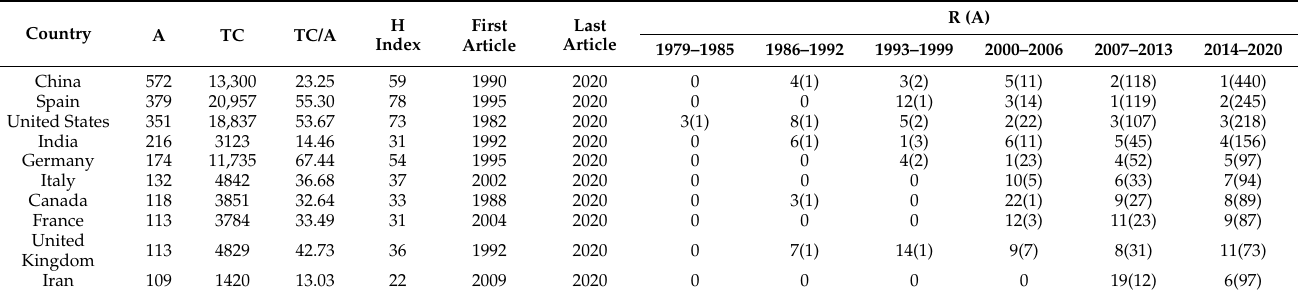
Table 7. Most relevant countries in number of